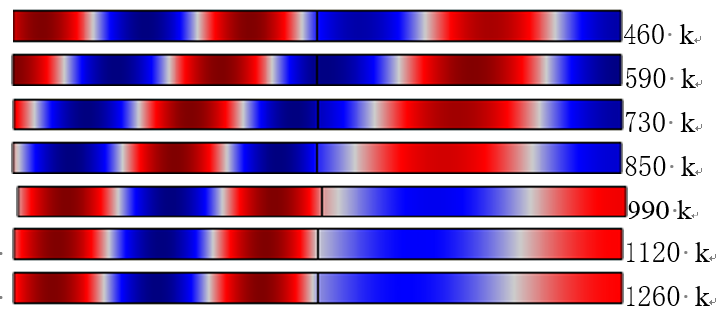
Figure 12. Acoustic pressure distribution of plane wave in seven reflection units with different temperatures.